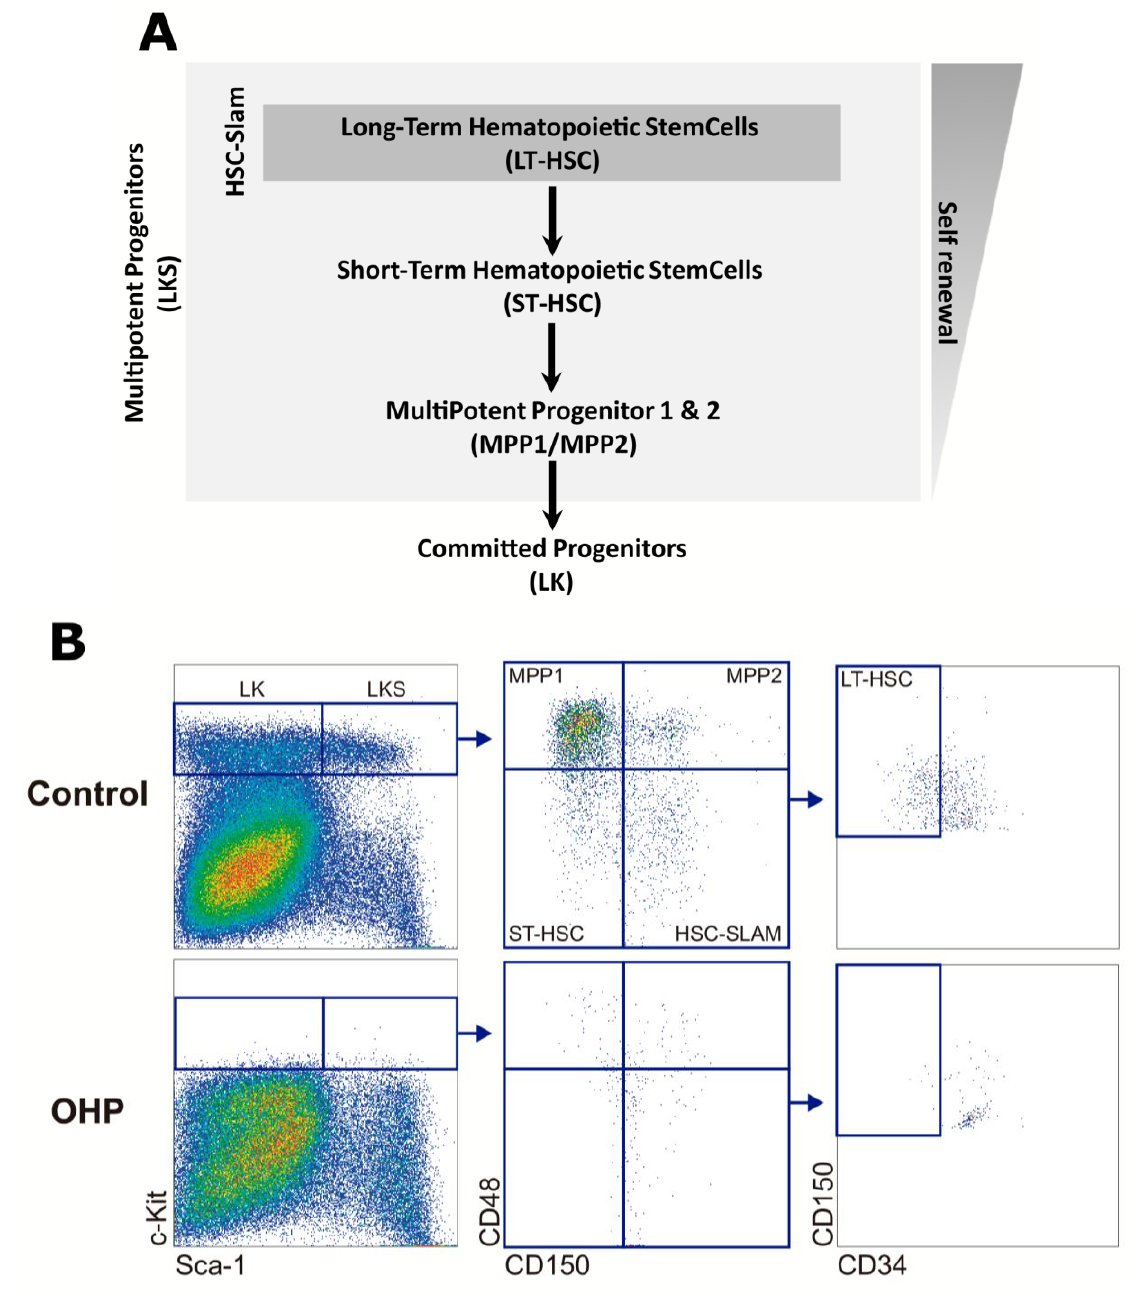
Figure 2. ( A ) Hierarchy/heterogeneity of the hematopoietic immature cell populations investigated in this study. ( B ) Gating strategy and hierarchical relationship of the hematopoietic populations of interest. Representative flow cytometry plots of a control ( upper panels ) and OHP-treated mouse ( lower panels ). After exclusion of debris and cell doublets, cells were gated on Lin-PI- population. Lin- viable cells were then used to investigate seven progenitor populations.